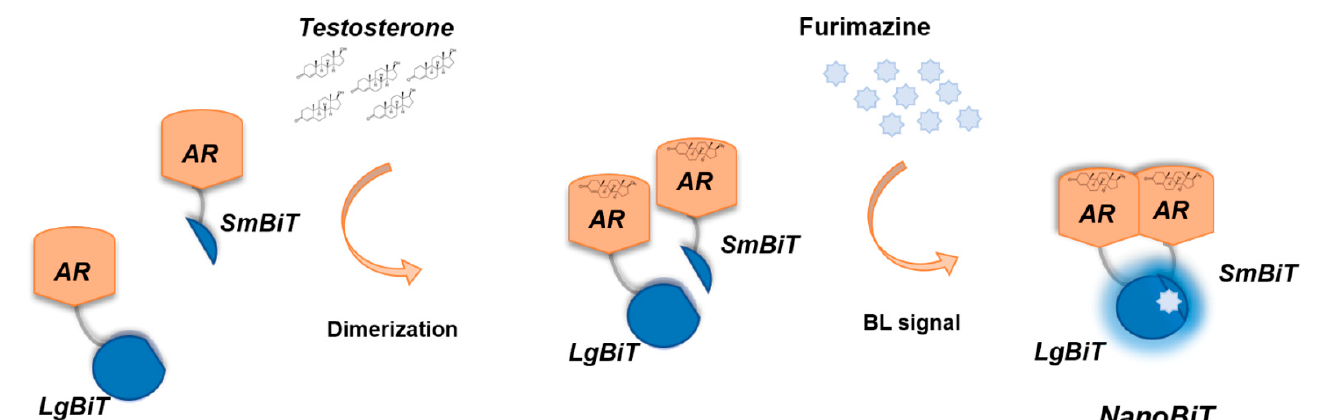
Figure 1. Schematic representation of the genetically encoded nanosensor principle. A large NanoLuc Binary Technology (NanoBiT) subunit (LgBiT) and small NanoBiT subunit (SmBiT) are genetically fused to the human androgen receptor (hAR), in the presence of testosterone, used as a model ligand with androgenic activity. Dimerization of hAR causes the reconstitution of NanoBiT luciferase, which in turn will emit light after the addition of the furimazine substrate.